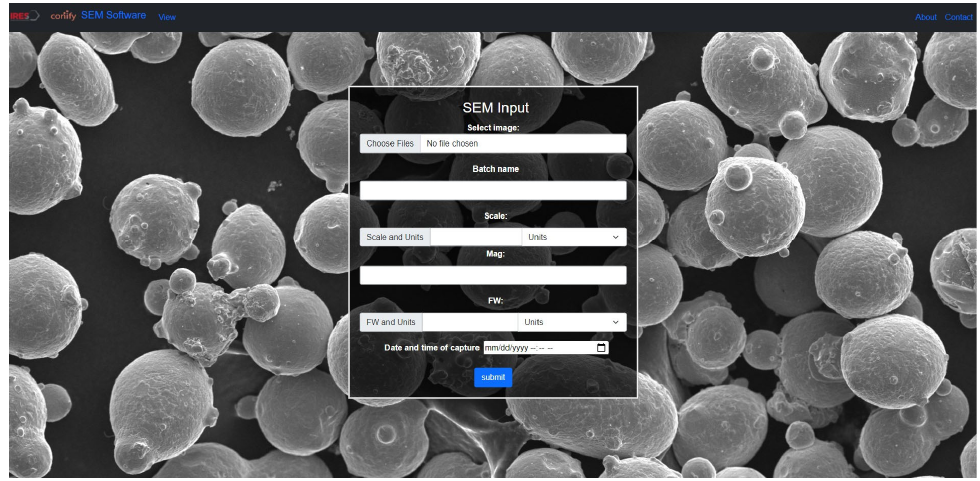
Figure 5. Step 1 of the user interface.